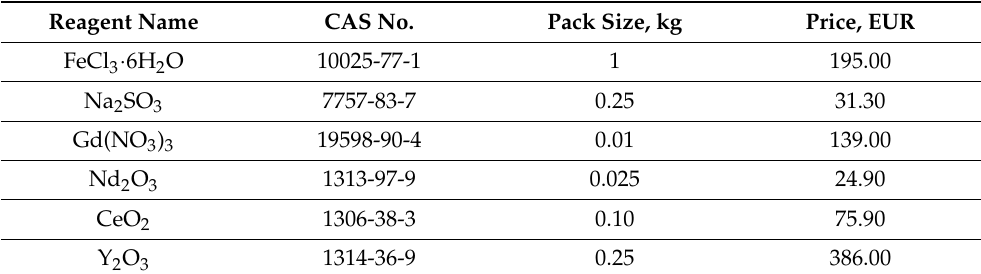
Table 3. Data on the cost of chemical reagents used for the production of nanocomposites. Reagent Name CAS